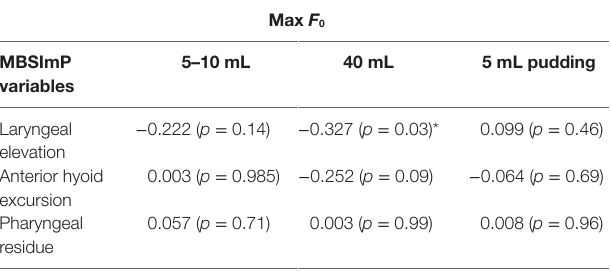
TaBle 4 | Correlations (Pearson r values) between maximum fundamental frequency (max F 0 ) and Modified Barium Swallow Impairment Profile (MBSImP)